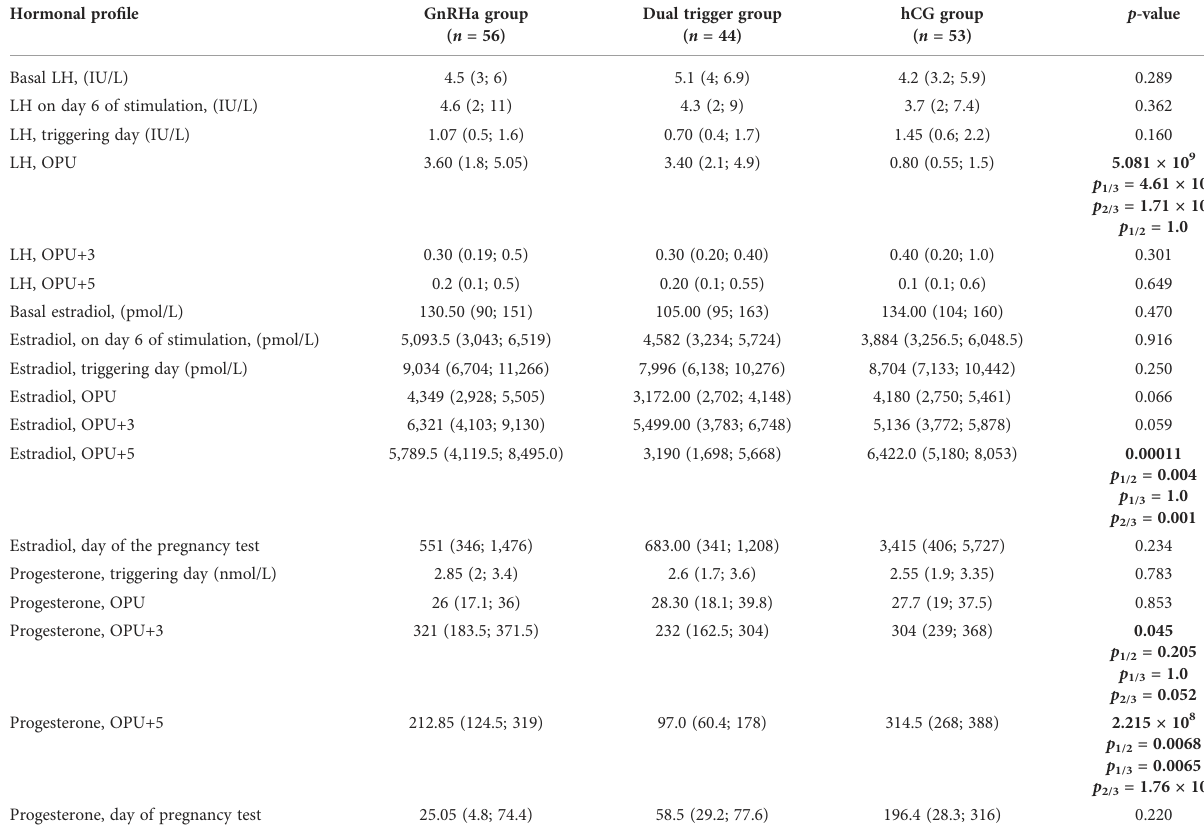
TABLE 2 LH, estradiol, and progesterone concentrations in blood serum. . Hormonal pro fi